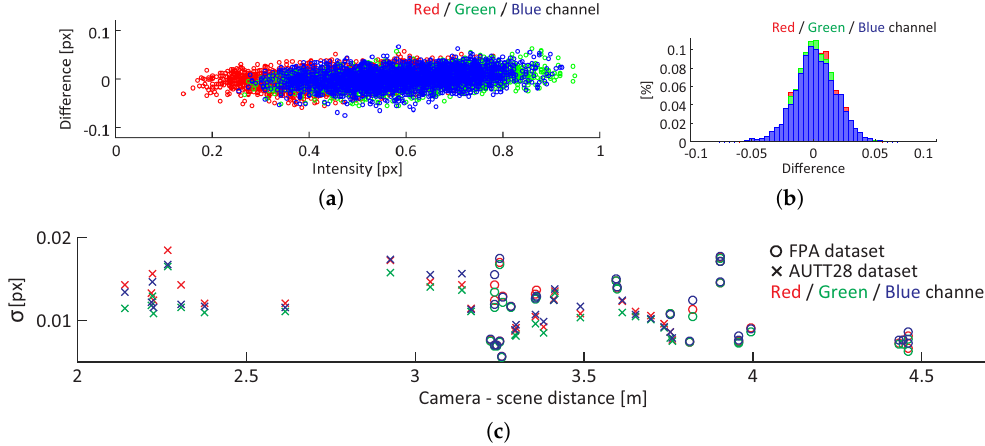
Figure 9. Characterization of image noise using an image from the FPA dataset: ( a ) image noise vs. pixel intensity, ( b ) distribution of noise per color channel and ( c ) standard deviation of estimated image noise for a series of images from multiple datasets and camera–scene distances, color-coded by the color